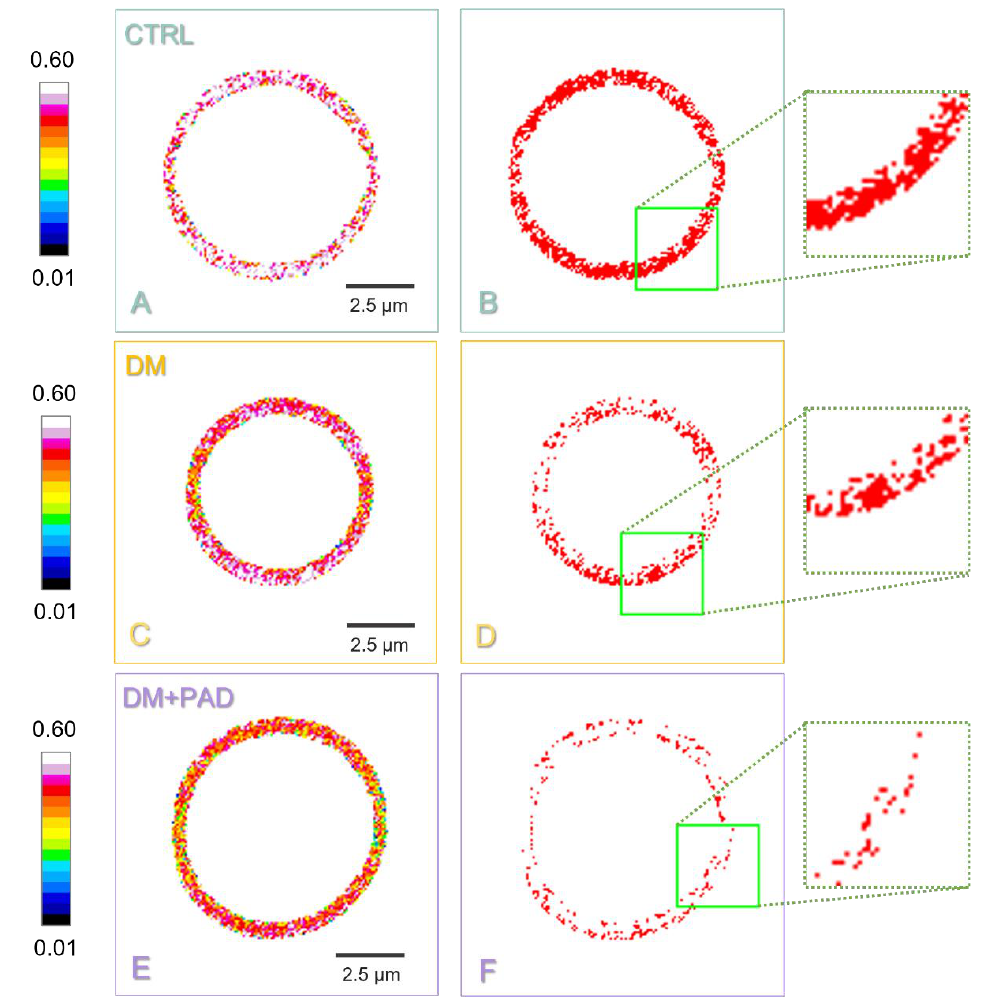
Figure 2. Identification of sub-micrometric LC domains in CTRL, DM, and DM+PAD red blood cells. The GP map of CTRL, DM, and DM+PAD RBC is reported in ( A , C , E ), respectively. Each pixel’s color reflects its GP value, according to the LUT reported along with the image (from blue for low GP — high fluidity, to white for high GP —low fluidity). Scale bar is 2.5 μm. A binary mask representing LC domains is shown in ( B , D , F ) for CTRL, DM, and DM+PAD RBC, respectively. From this analysis, a fine characterization of the number, size and shape of LC domains can be obtained for each RBC. A magnification (dotted green frame) of domains is represented to allow qualitatively appreciating differences between CTRL, DM, and DM+PAD subjects, where a progressive trend towards the presence of smaller LC domains can be observed.